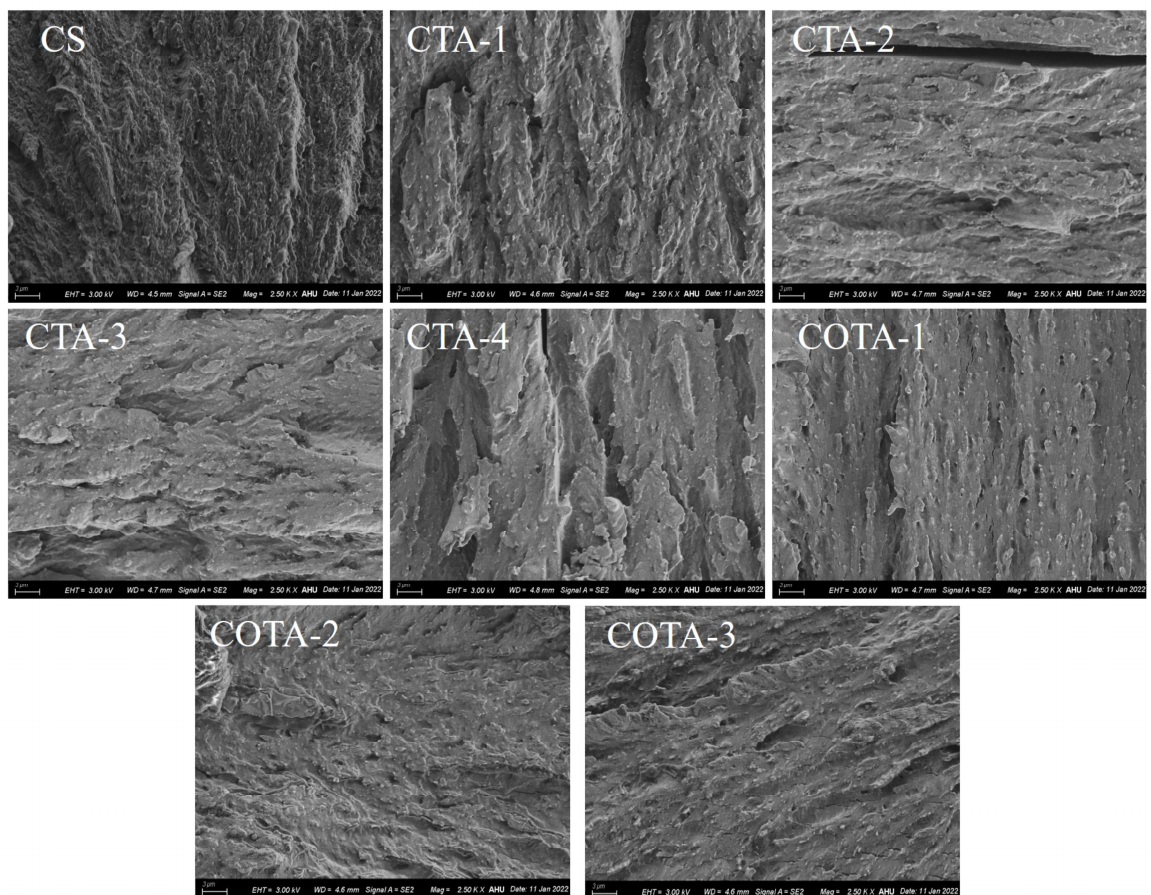
Figure 9. SEM images of the tensile fracture sections in the CS, CTA, and COTA films.